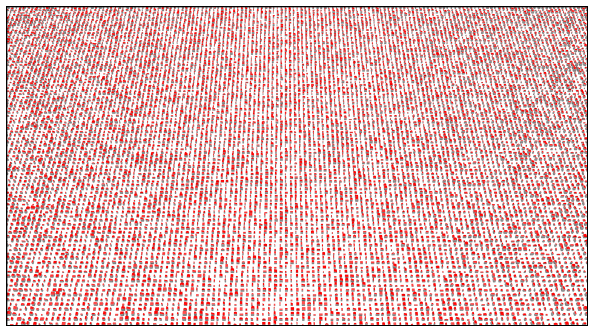
Figure 3: The CityGML realisation of the XML dataset of the randomly generated buildings. The dataset contains 40000 build- ings (in a grid 200 × 200).